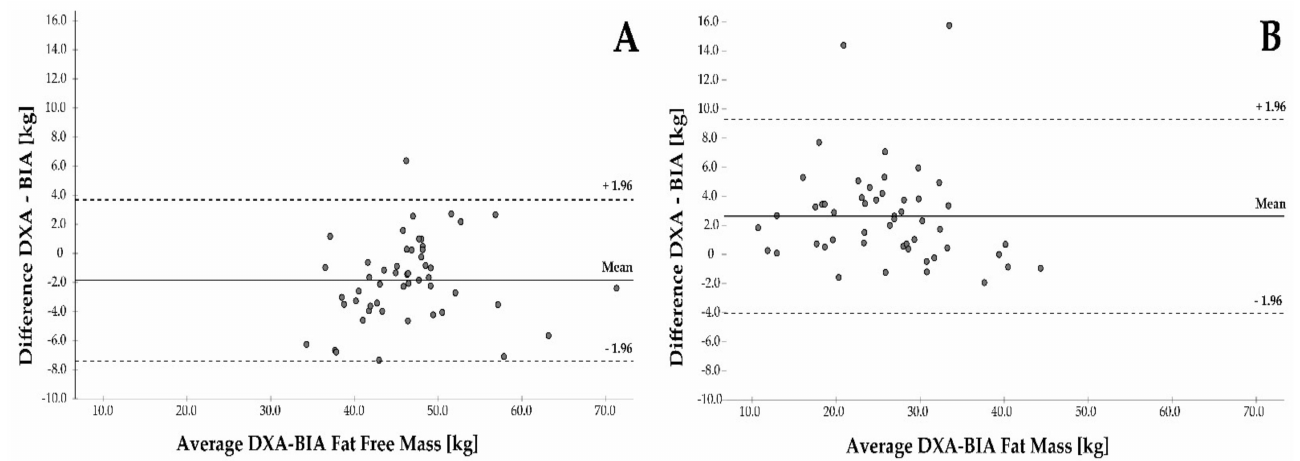
Figure 3. Bland − Altman analysis for the fat-free mass (FFM ( A )) measured and for the fat mass (FM ( B )) measured by the BIA and